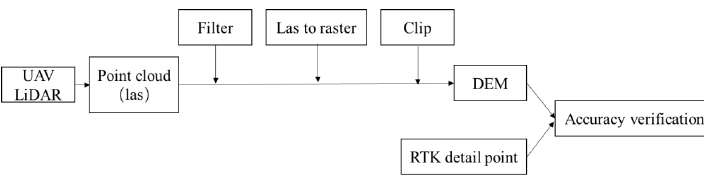
Figure 7. Flow chart of LiDAR digital elevation model (DEM) generation.